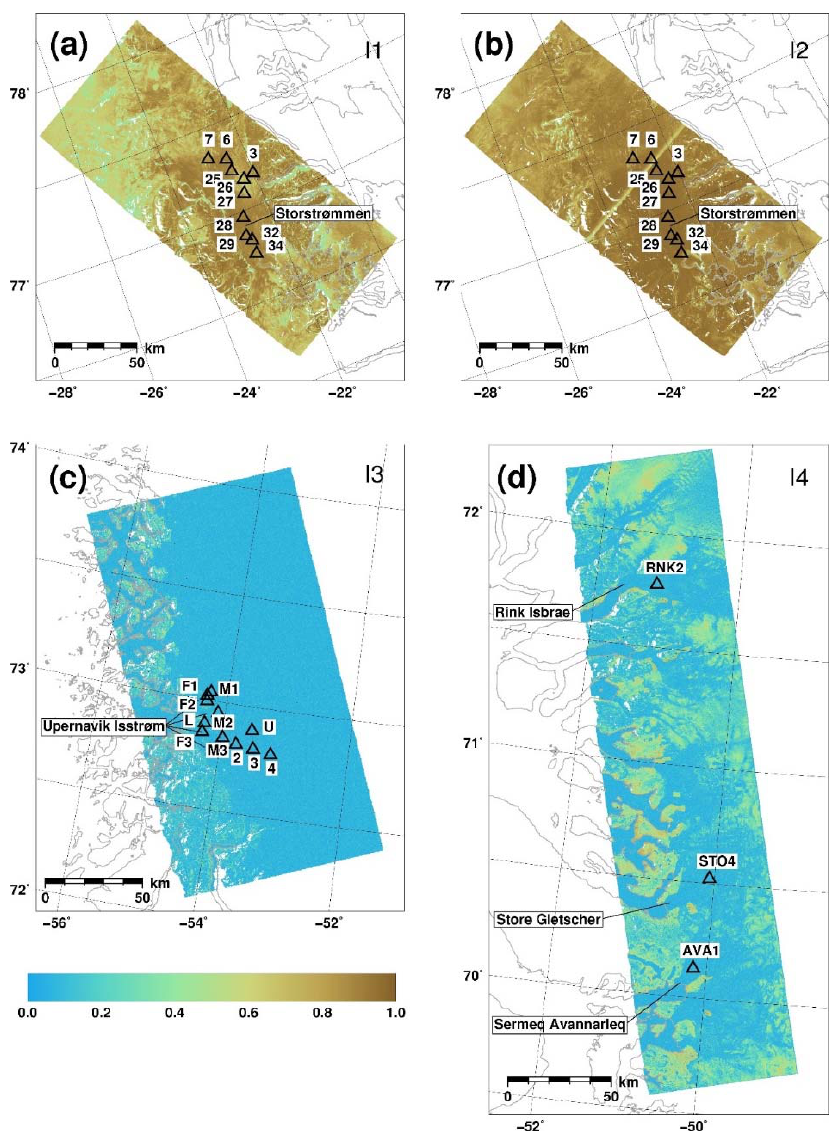
Figure 2. Interferometric coherence of the I1 ( a ); I2 ( b ); I3 ( c ) and I4 ( d ) SAR datasets (Table 1).